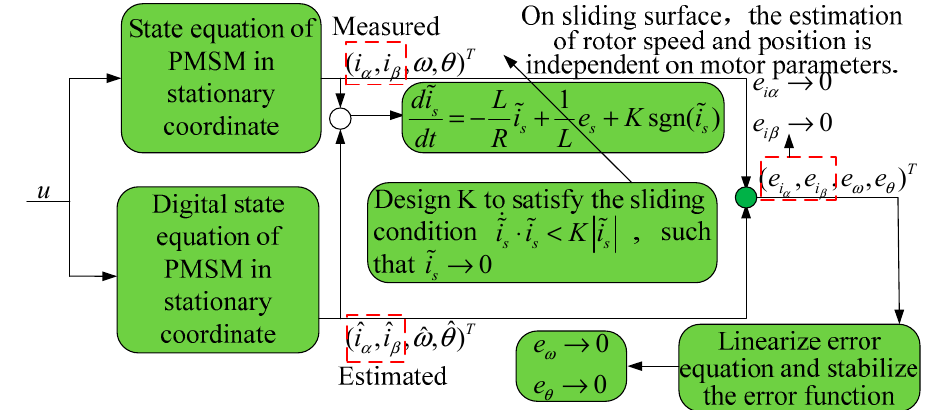
Figure 7. Design scheme of operation estimation algorithm.